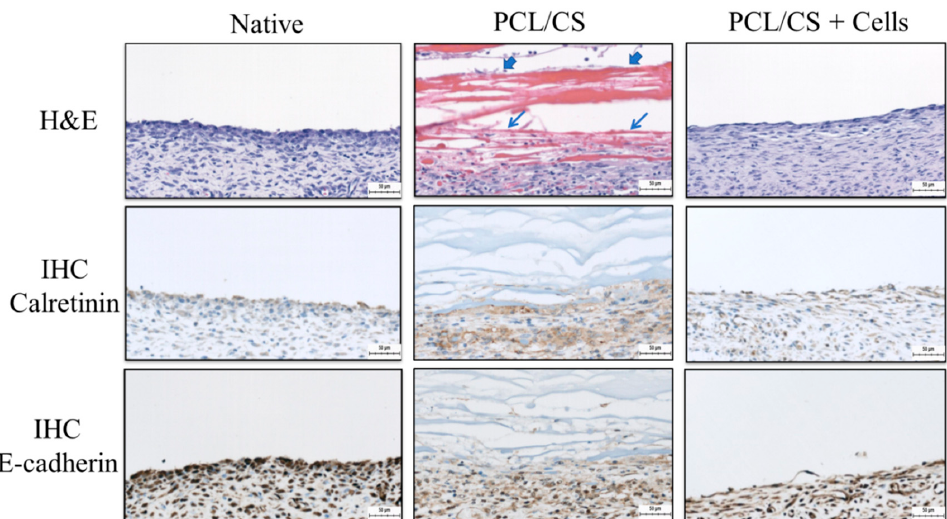
Figure 10. The hematoxylin and eosin (H&E) and immunohistochemical (IHC) staining of calretinin and E-cadherin of the mesothelium tissue 7 days post-implantation (bar = 50 µm). The abraded parietal peritoneum was repaired with PCL/CS or PCL/CS + cells as the acellular and the cellular groups, respectively. The PCL/CS + cells sample is prepared by culturing mesothelial cells in PCL/CS membrane scaffold for 7 days in vitro before implantation. The native mesothelium is used for comparison on the left. The arrowheads indicate residual membrane filaments, and arrows indicate the inflammatory cell layer in PCL/CS.